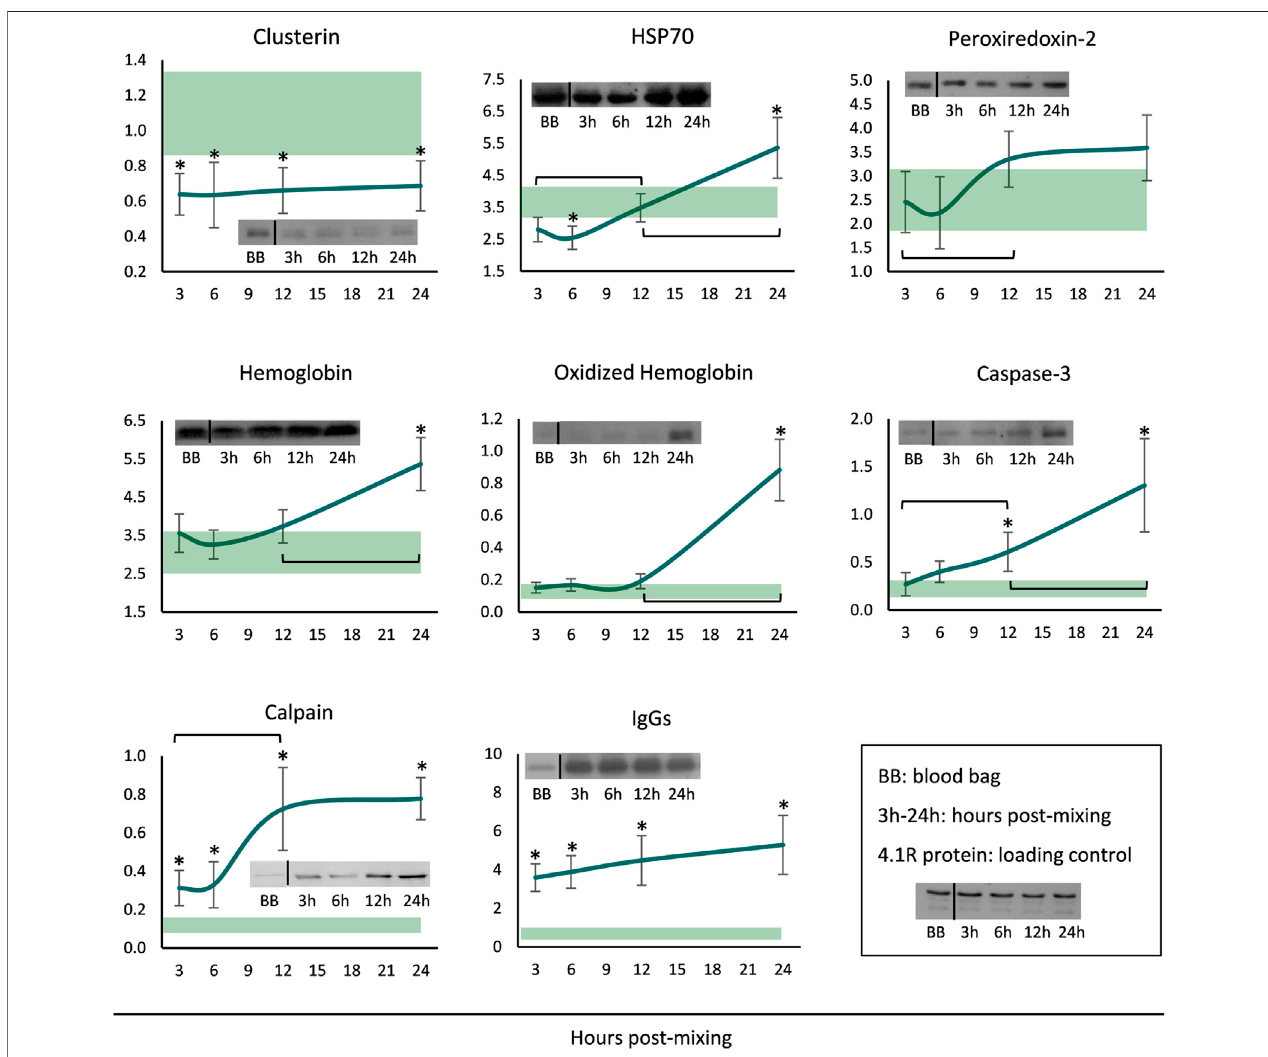
FIGURE 4 | Protein binding pro fi le (arbitrary units after normalization to 4.1 R protein levels) of reconstituted long-stored red blood cells in freshly drawn plasma. Baseline levelsofstoredRBCsinthecold(4 ° C)areshownbytransparent horizontal bands(bandthicknessisrepresentative ofthestandarddeviation[SD]).(*) p < 0.050 reconstitutedRBCsvs.baselineRBCsinthecold;bracketsshowdifferenceswith p < 0.050between3,12and24 hpostreconstitution;inserts:indicativewesternblots of the selected proteins.